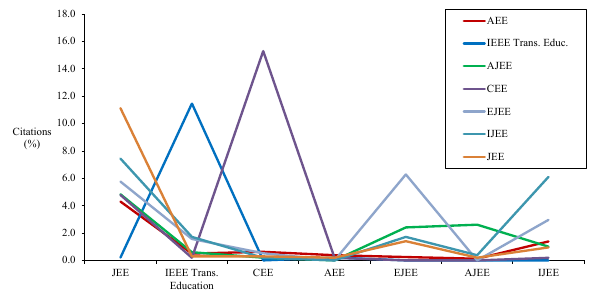
Figure 2. Comparison of citation analysis of the 7 journals in 2011.